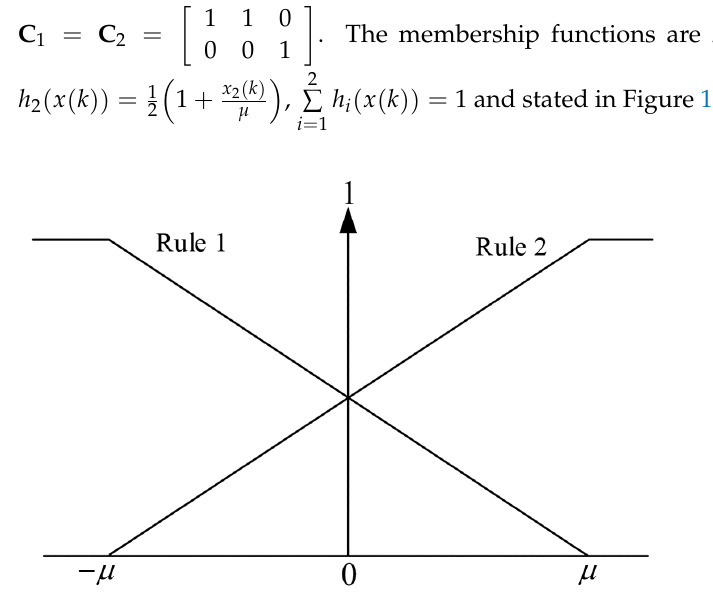
h . Figure 1. Membership functions h i